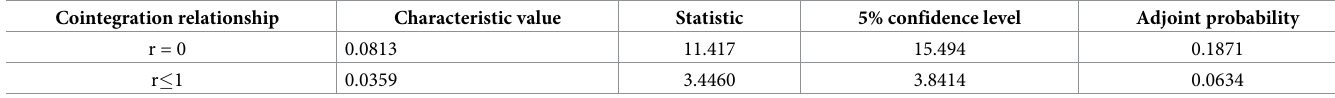
Table 2. Cointegration relationship (Trace) test results.